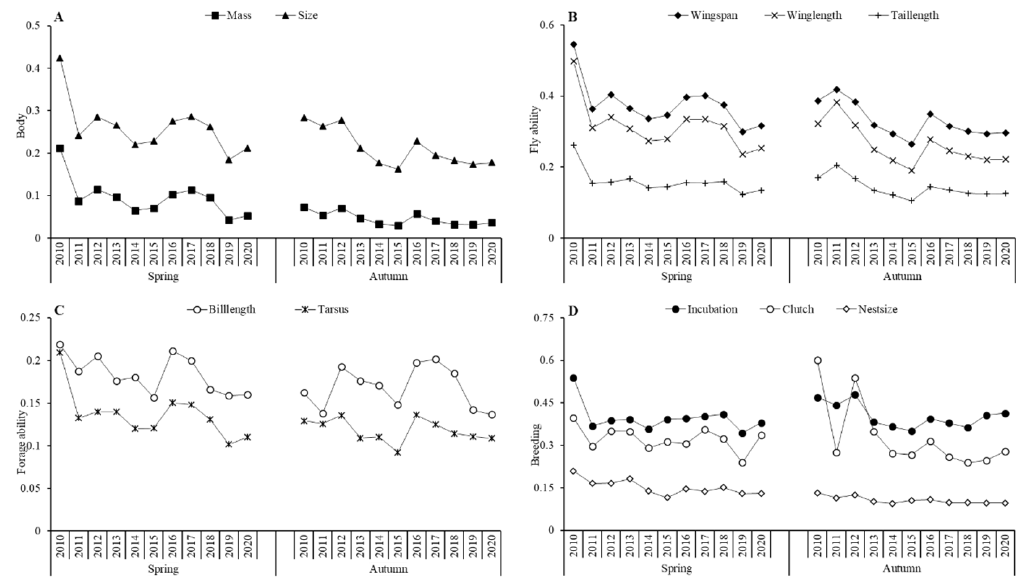
Figure 3. Annual and seasonal trends of community weighted mean (CWM) values: ( A ) Body (mass and size), ( B ) Flying ability (wingspan, wing length, and tail length), ( C ) Foraging ability (bill length and tarsus), and ( D ) Breeding (incubation, clutch, and nest size).